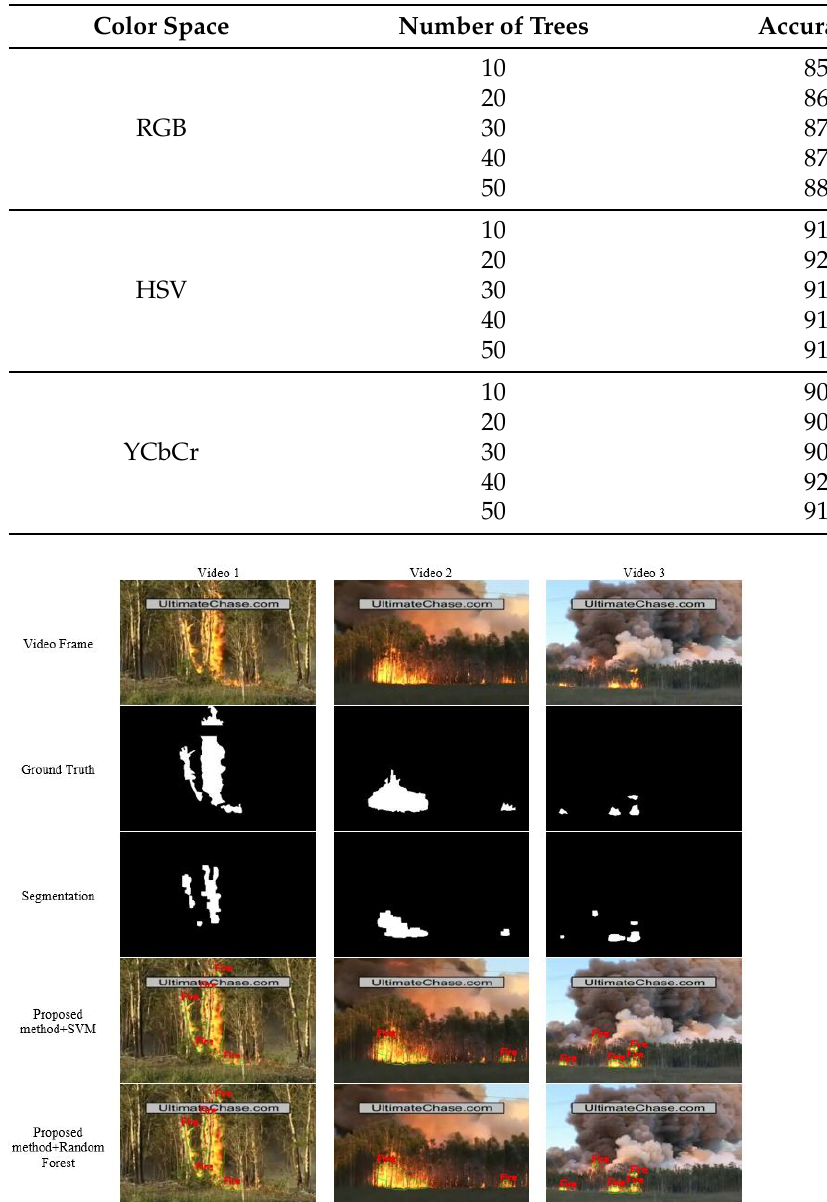
Table 4. Classification result using Random Forest.